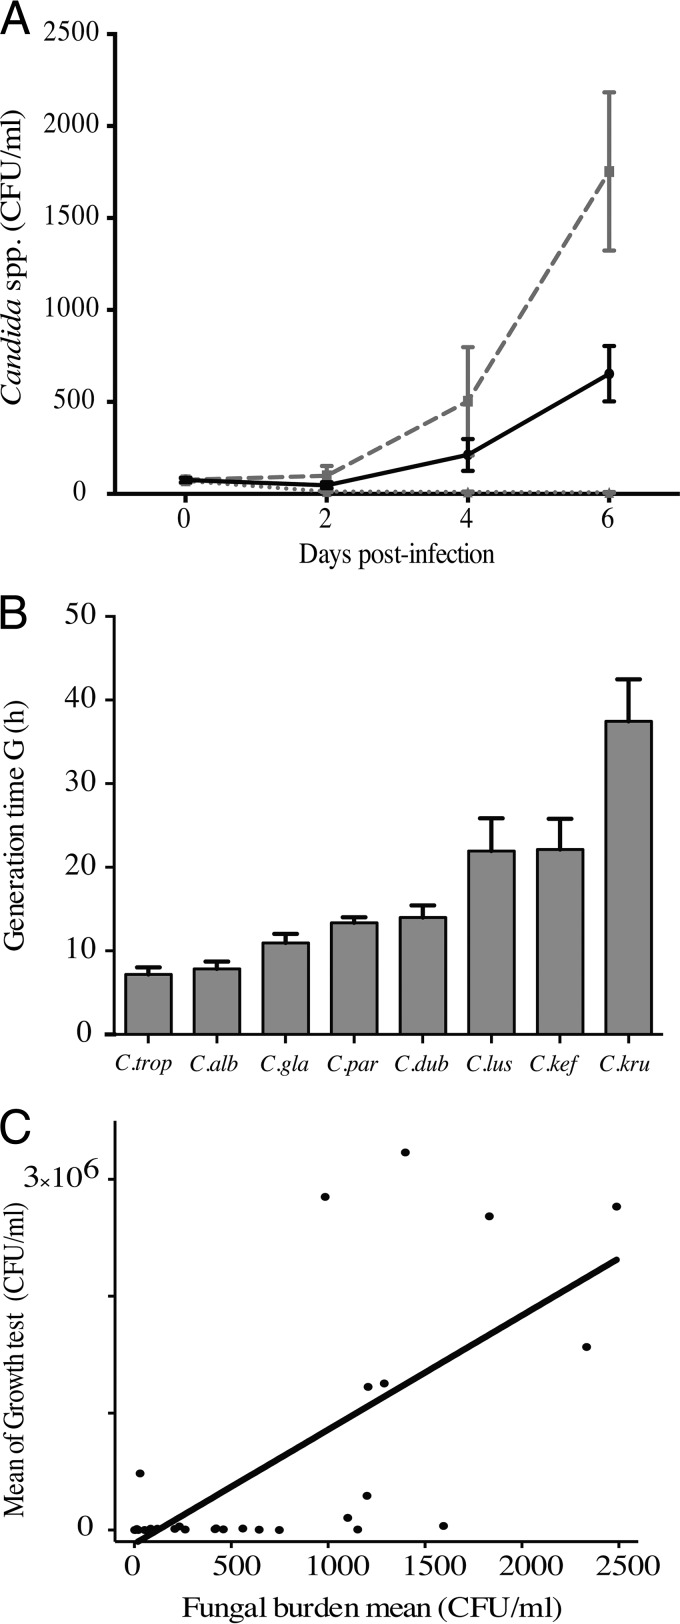
Dynamics of Candida proliferation within immune infiltrates. (A) The fungal burden was determined at 0, 2, 4, and 6 days postinfection. Data are the means ± SEM of the fungal burden of 32 clinical isolates of Candida from immune infiltrates of 10 subjects. The black line represents the mean ± SEM of the fungal burden of 32 clinical isolates of Candida and of 10 subjects. The gray dashed line represents the mean ± SEM of the fungal burden of C. albicans immune infiltrates, while the gray dotted line shows the mean ± SEM of the fungal burden of C. krusei immune infiltrates. (B) Generation time (G) and growth analysis of Candida species isolates. Shown are means + SEM for generation time for Candida species. (C) Significant positive correlation between mean of growth test after 6 days and mean of fungal burden on day 6 after infection.